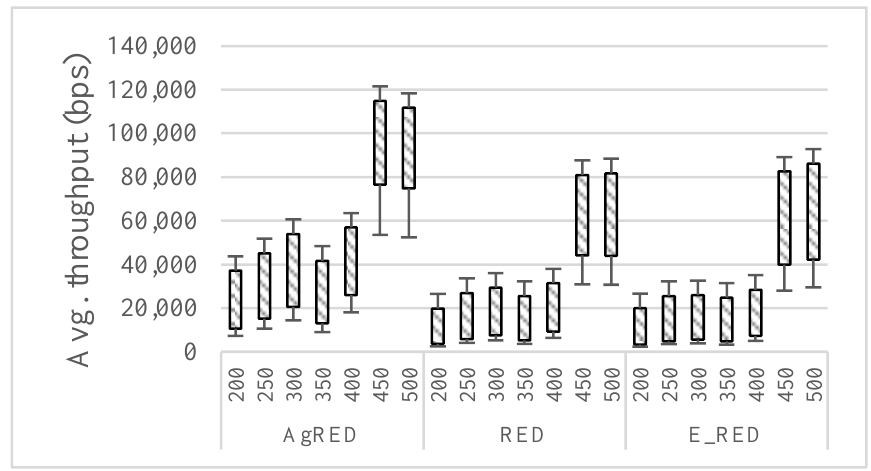
Figure 14. Box-plot of throughput (UDP) vs. number of nodes. In order to highlight the importance of AQM techniques in NB IoT MANET, it is important to compare AgRED (an AQM technique) with two passive queue management schemes. Figure 15 presents the comparison of the proposed scheme AgRED with passive queue management schemes, namely drop-tail and drop-head. Average end-to-end delay has been presented against the increasing number of nodes in Figure 15a, where drop-tail shows losses in delay due to no management of the queue-length. On the other hand, drop-head or drop-from-the-front shows incredible gains (less delay) as compared to drop-tail, while falling short in comparison to AgRED. The average recorded values for drop-head point to a gain of 2.15 times less delay as compared to drop-tail but 1.64 times higher delay as compared to AgRED. Figure 15b shows that regardless of the queue man- agement scheme used, the significance of speed is negligible as all the schemes remain